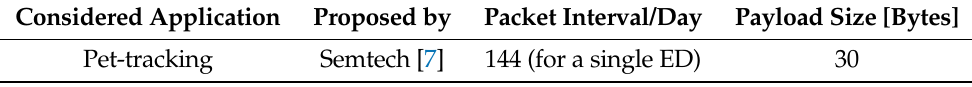
Table 3. Pet-tracking application with various requirements